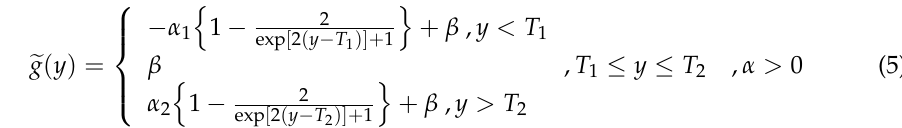
The curve of asymmetric-hyperbolic tangent grey quality compensation function is shown in Figure 2.